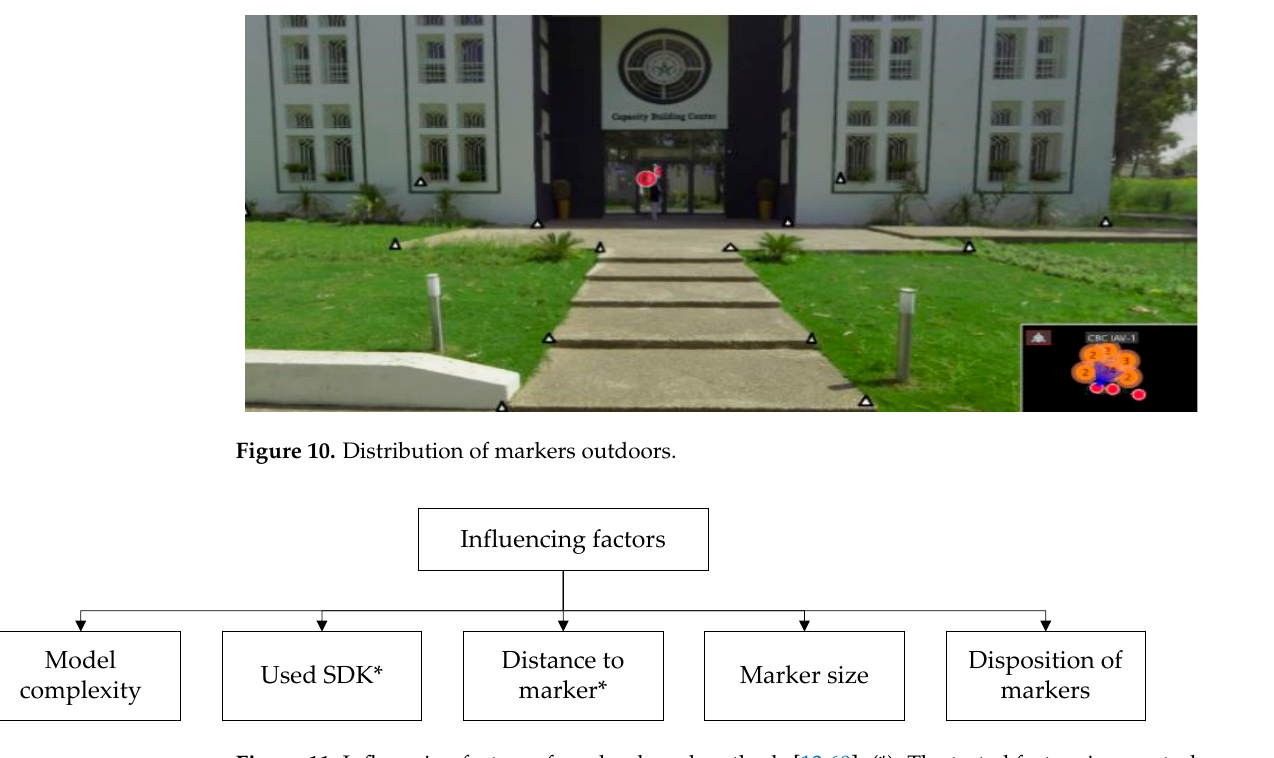
Figure 11. Influencing factors of marker-based methods [13,60]. (*): The tested factors in our study.